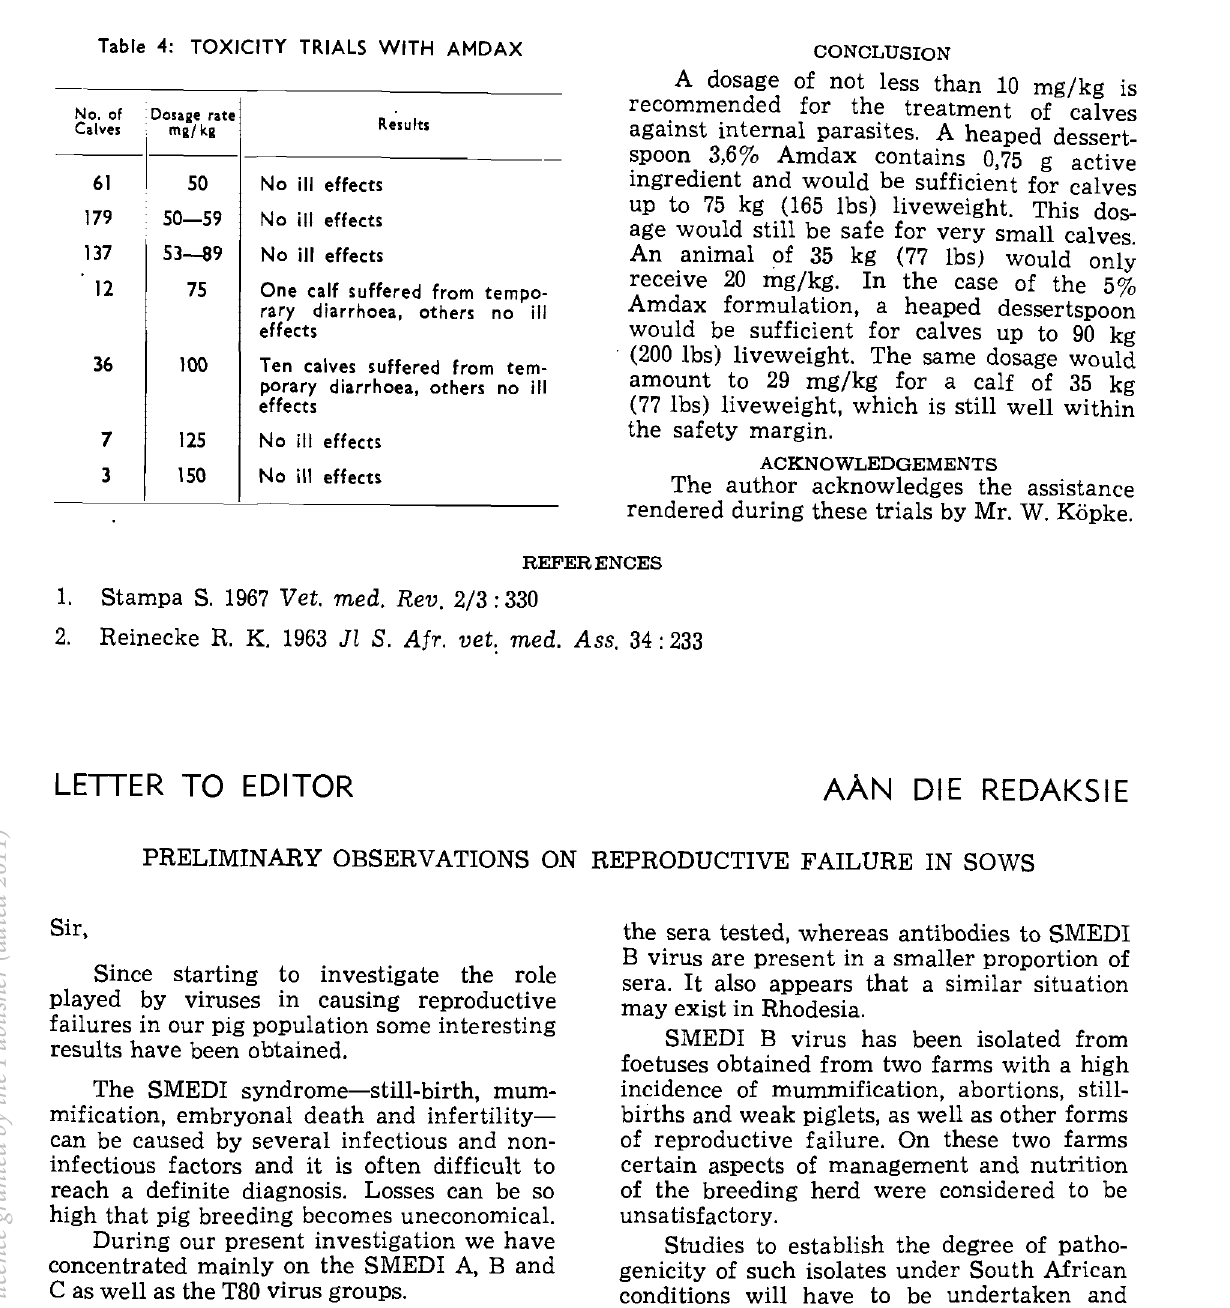
Table 4: TOXICITY TRIALS WITH